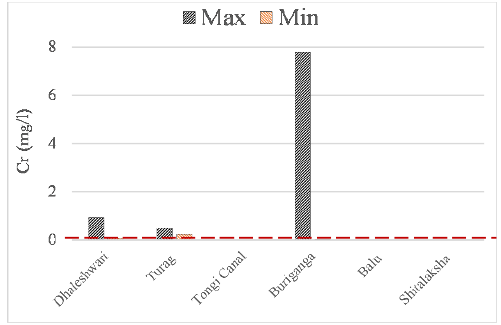
Figure 11. Concentrations for Cr in the peripheral rivers of Dhaka with WHO standard in dotted line (0.05 mg/L).